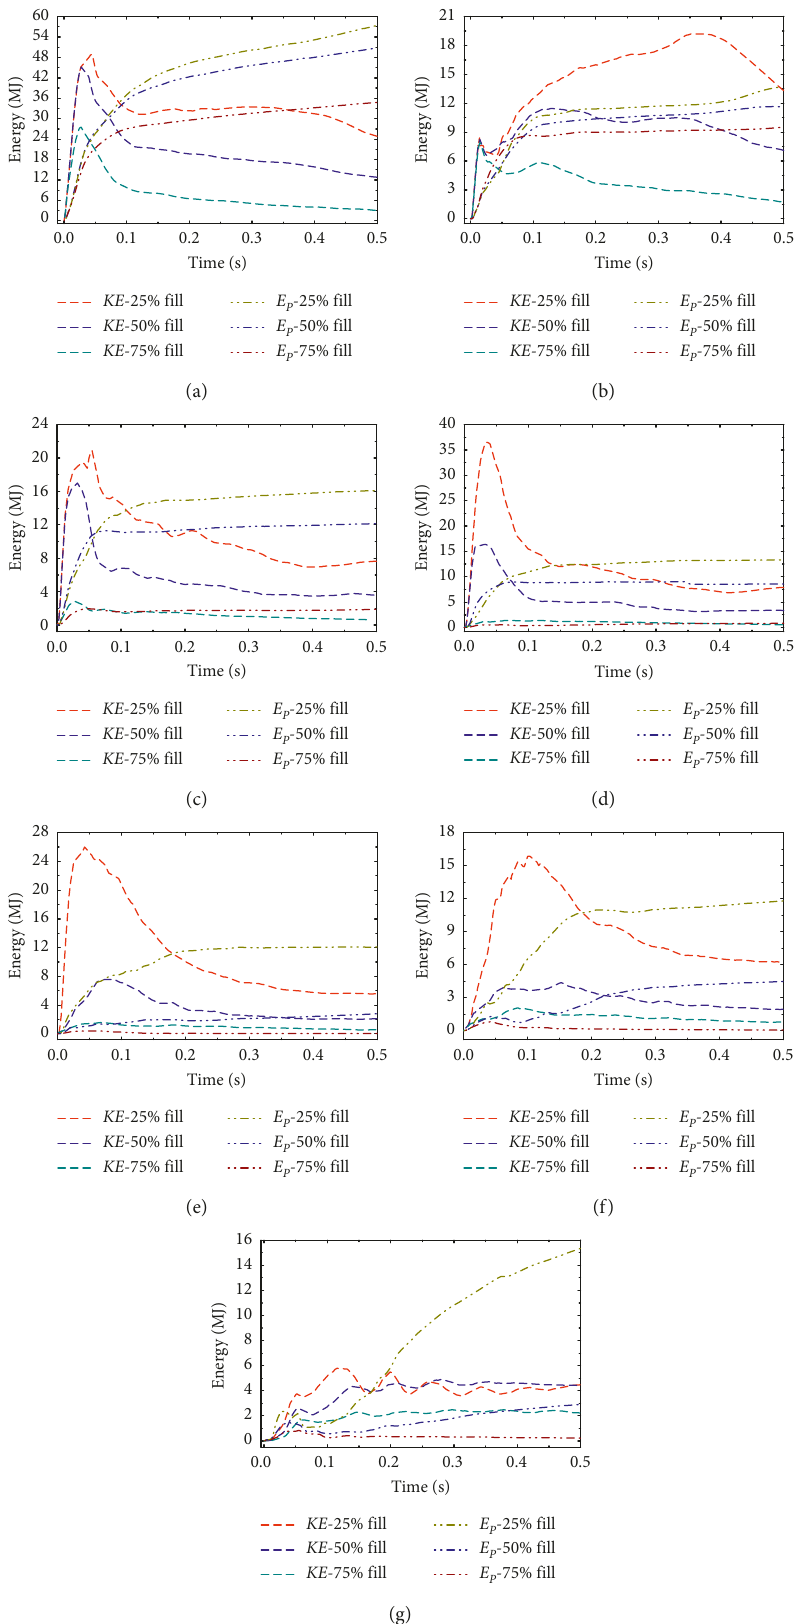
Figure 15: The energy curves comparison under intensity of 1500 kg TNTequivalent mass explosion. (a) Wind girders (ring stiffeners). (b) 8 th wall. (c) 6 th wall. (d) 5 th wall. (e) 3 rd wall. (f) 1 st wall. (g) Bottom